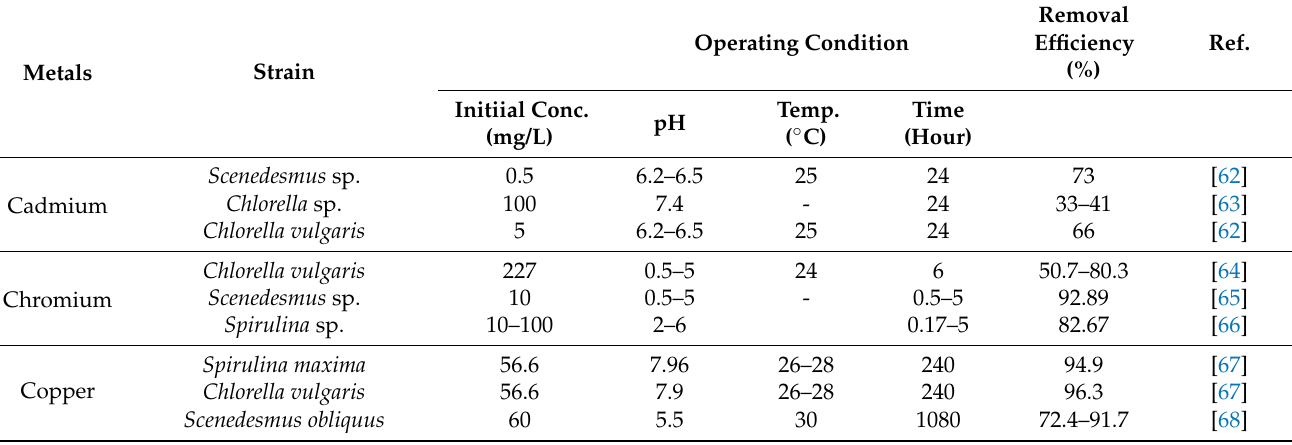
Table 2. Microalgal removal of metals from